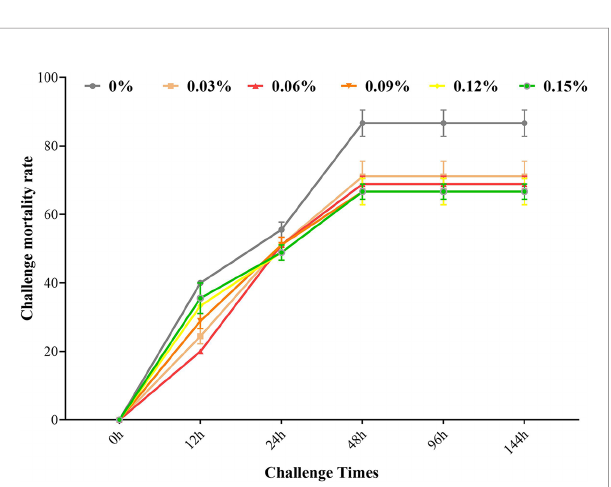
FIGURE 5 | The relative expressions of vital gene in NF- k B signaling pathway with different levels of TB supplementation. (A) TNF- a , tumor necrosis factor- a ; IL-8, interleukin 8; IL-1 b , interleukin 1 b ; NF- k B, nuclear factor-kappa (B) ; (B) IL-10, interleukin 10; TGF- b , transforming growth factor- b . Data are expressed as means with S.E. Value with different superscripts are signi fi cantly different (P < 0.05).